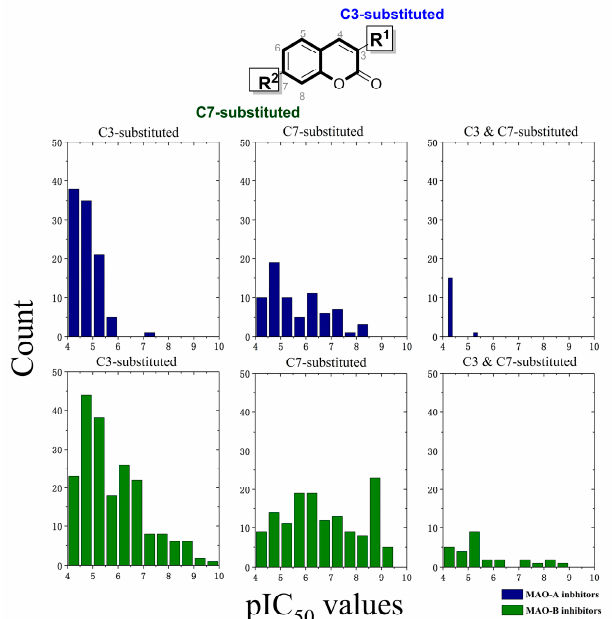
Figure 1. Inhibition results of C3 and C7-subsituted coumarin derivatives against h MAO-A and h MAO-B (data collected from ChEMBL v24).